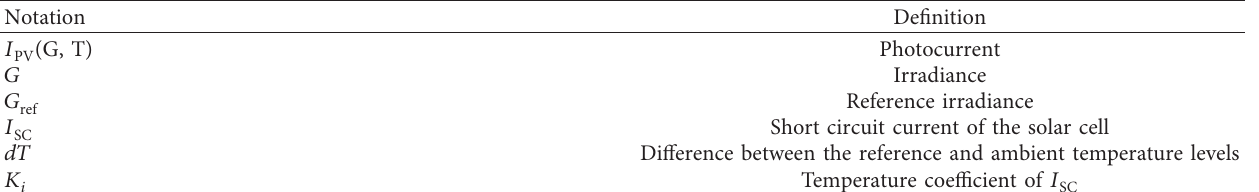
Table 8: Summary of notations and